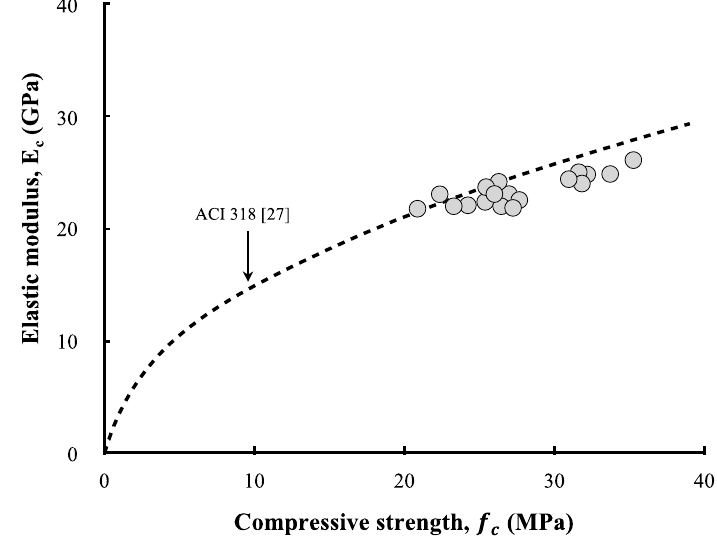
Figure 17. Variation of the elastic modulus of LRM concrete as a function of cement type.